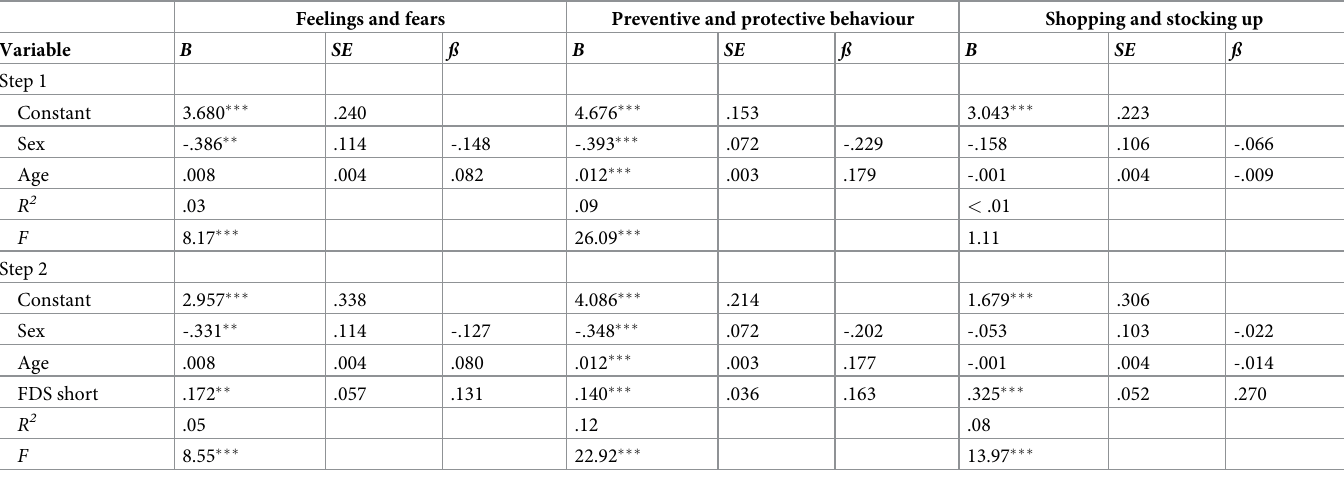
Table 3. Multiple regression analysis predicting the attitudes or behaviours related to the COVID-19 pandemic from age, sex, and food disgust sensitivity, N = 519. Feelings and fears Preventive and protective behaviour Shopping and stocking